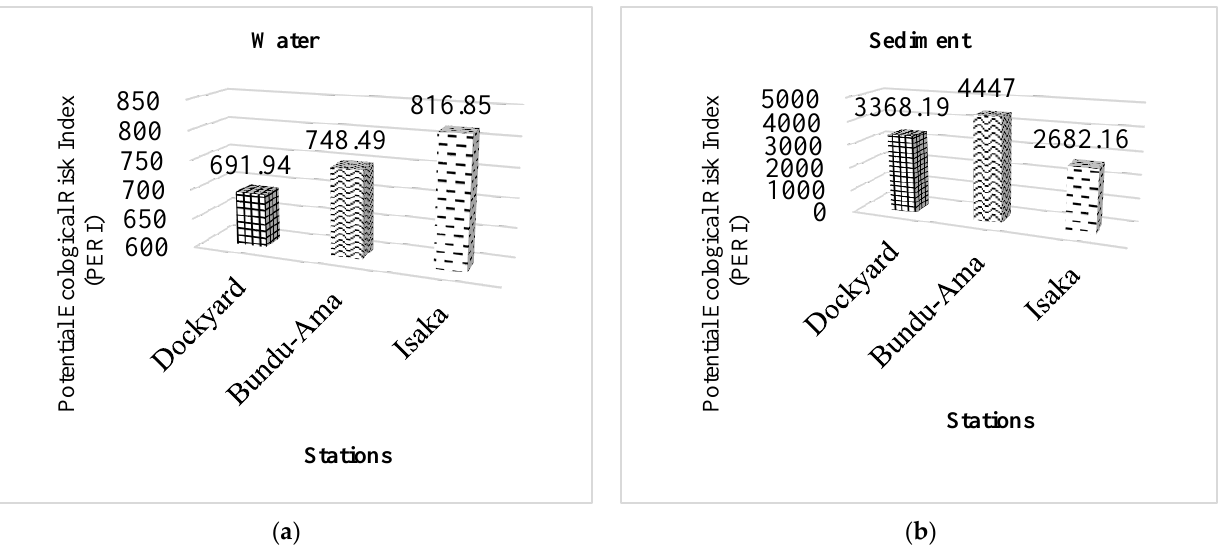
Table 3. Contamination factor (C f ) and degree of contamination (DC) of Cd, Pb, Zn, Fe, As, and Cu in the Isaka–Bundu tidal mangrove swamp.